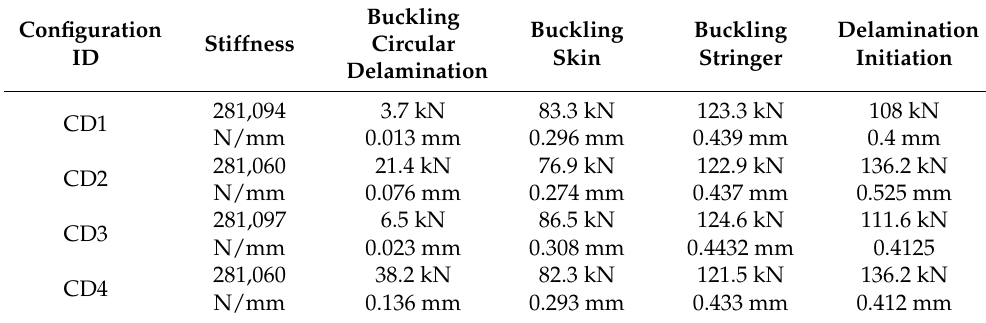
Table 3. Buckling loads and displacements for CD1–CD4